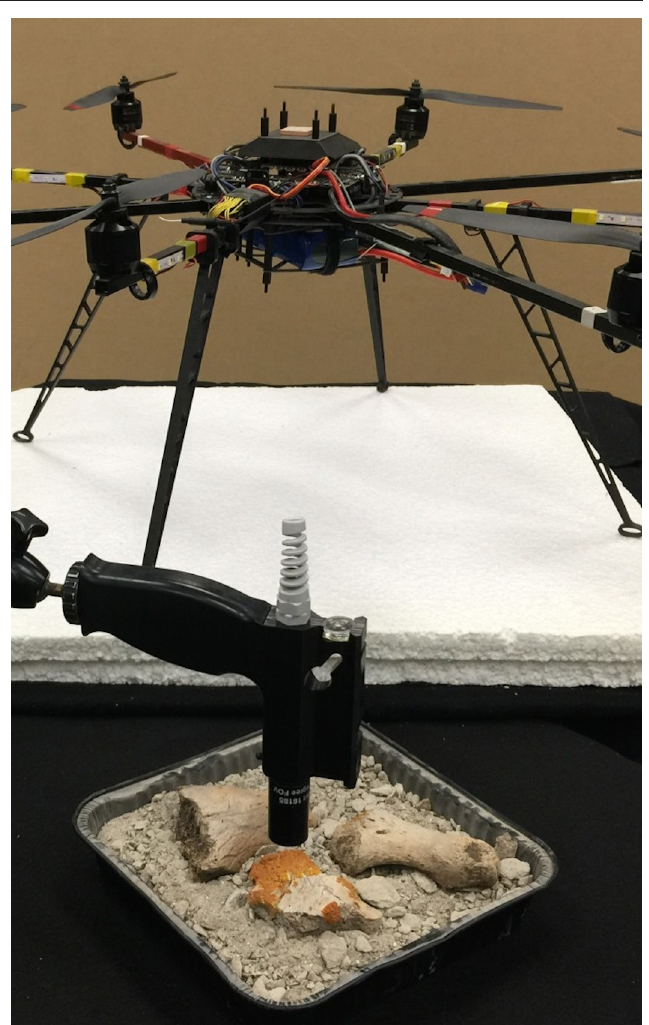
Figure 2. Laboratory-based measurements of fossils com- bined with RPAS imagery make this research unique and